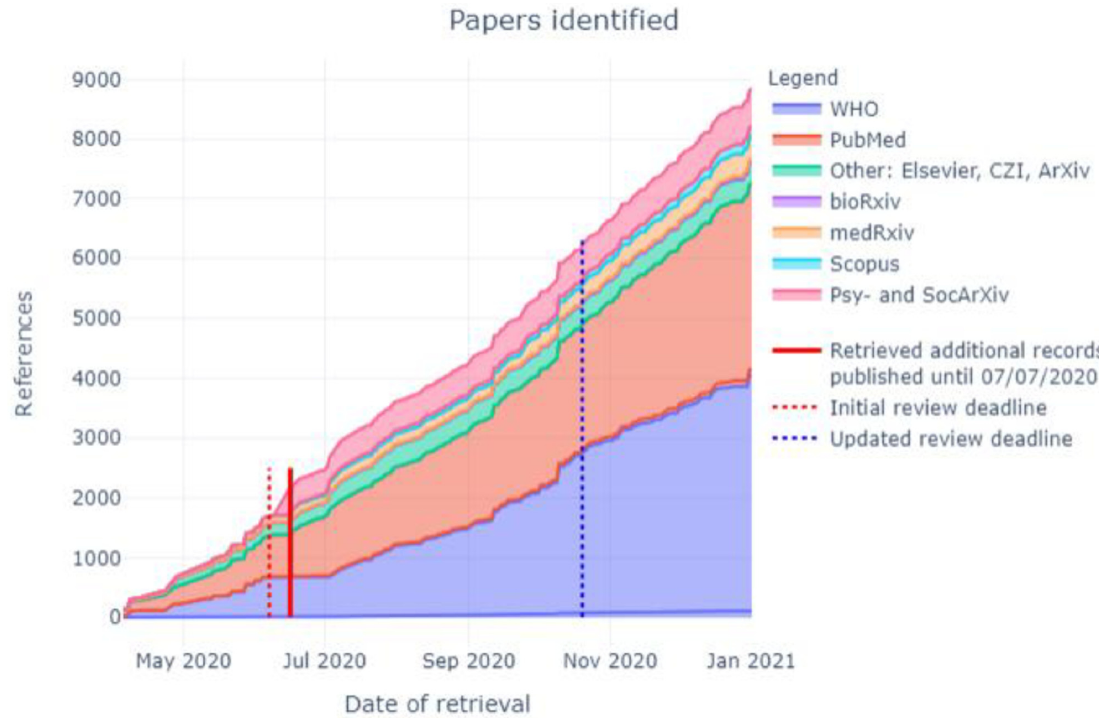
Figure 3. Number of articles identified by database and repository over time.